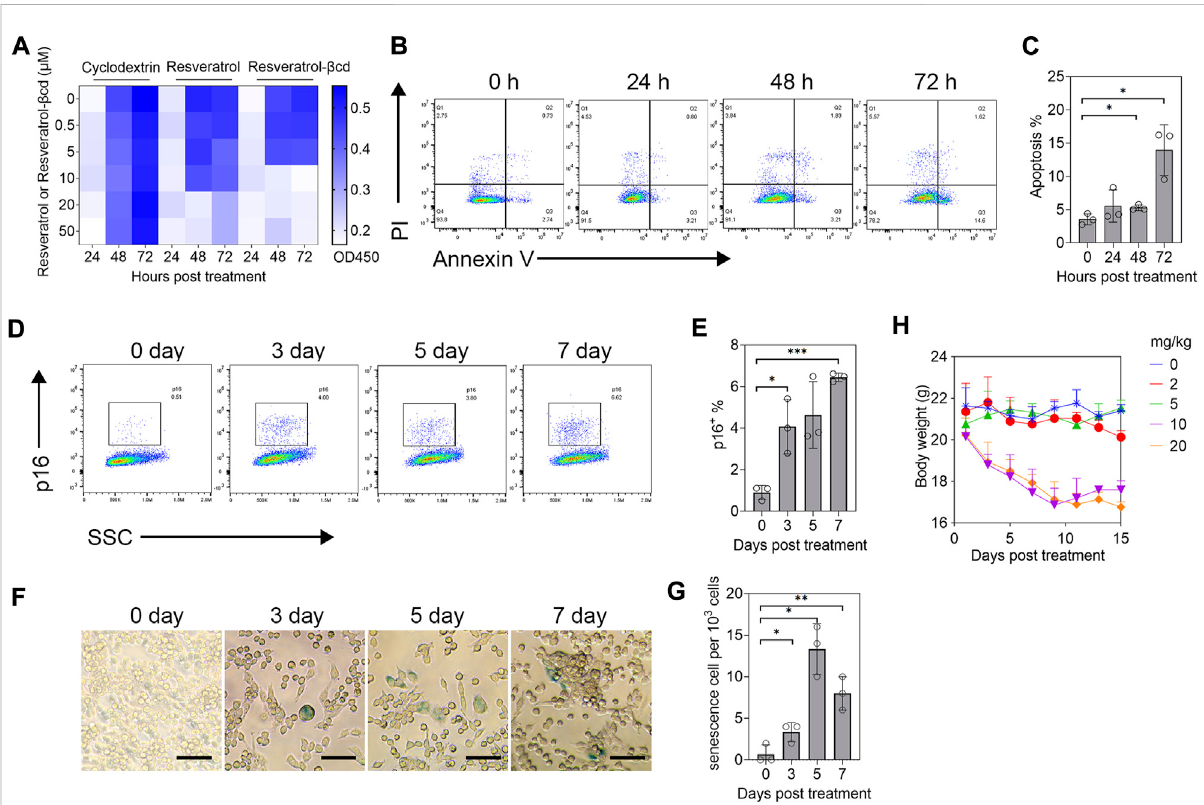
FIGURE 1 Evaluation of resveratrol- β cd anti-tumor effects in vitro . (A) CCK-8 assessment of the inhibitory effects of resveratrol- β cd or resveratrol or an equal volume of cyclodextrin on cell proliferation at the indicated times and concentrations. The heatmap values are the average values of three replicates. (B) Typical diagram of apoptosis fl ow cytometry after treatment of LLC cells with 10 μ M resveratrol- β cd at different time points. (C) Statisticalresultsofapoptosisattheindicatedtimes.Errorbar=mean±S.D. (D) Typical fl owcytometrydiagramofLLCcellsenescenceanalysis aftertreatmentwith10 μ Mresveratrol- β cdfortheindicatedtimes.p16wasusedasthemarkerofsenescence. (E) Statisticalresultsofthesenescence analysis. Error bar = mean ± S.D. (F) Typical β -gal graph of LLC cells after treatment with 10 μ M resveratrol- β cd at the indicated times.